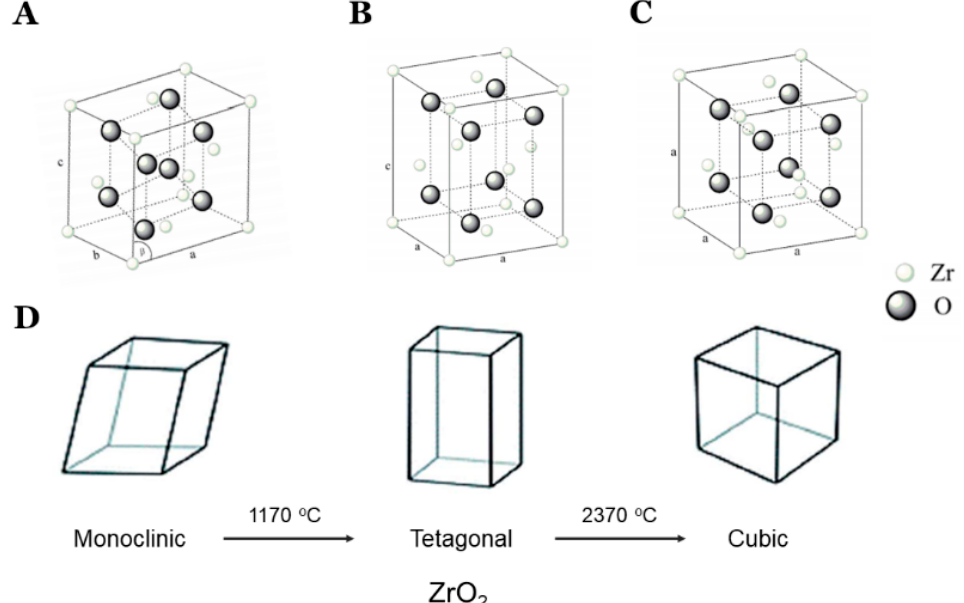
Figure 1. Different phases and phase transformation of zirconia. Monoclinic ( A ), tetragonal ( B ), and cubic structure ( C ). Zirconia can have 3 polymorphs depending on temperature: monoclinic at <1170 °C, tetragonal between 1170 °C and 2370 °C, and cubic at >2370°C ( D ). Adapted with permission from Ref. [11]. 2019, MDPI, Basel, Switzerland.